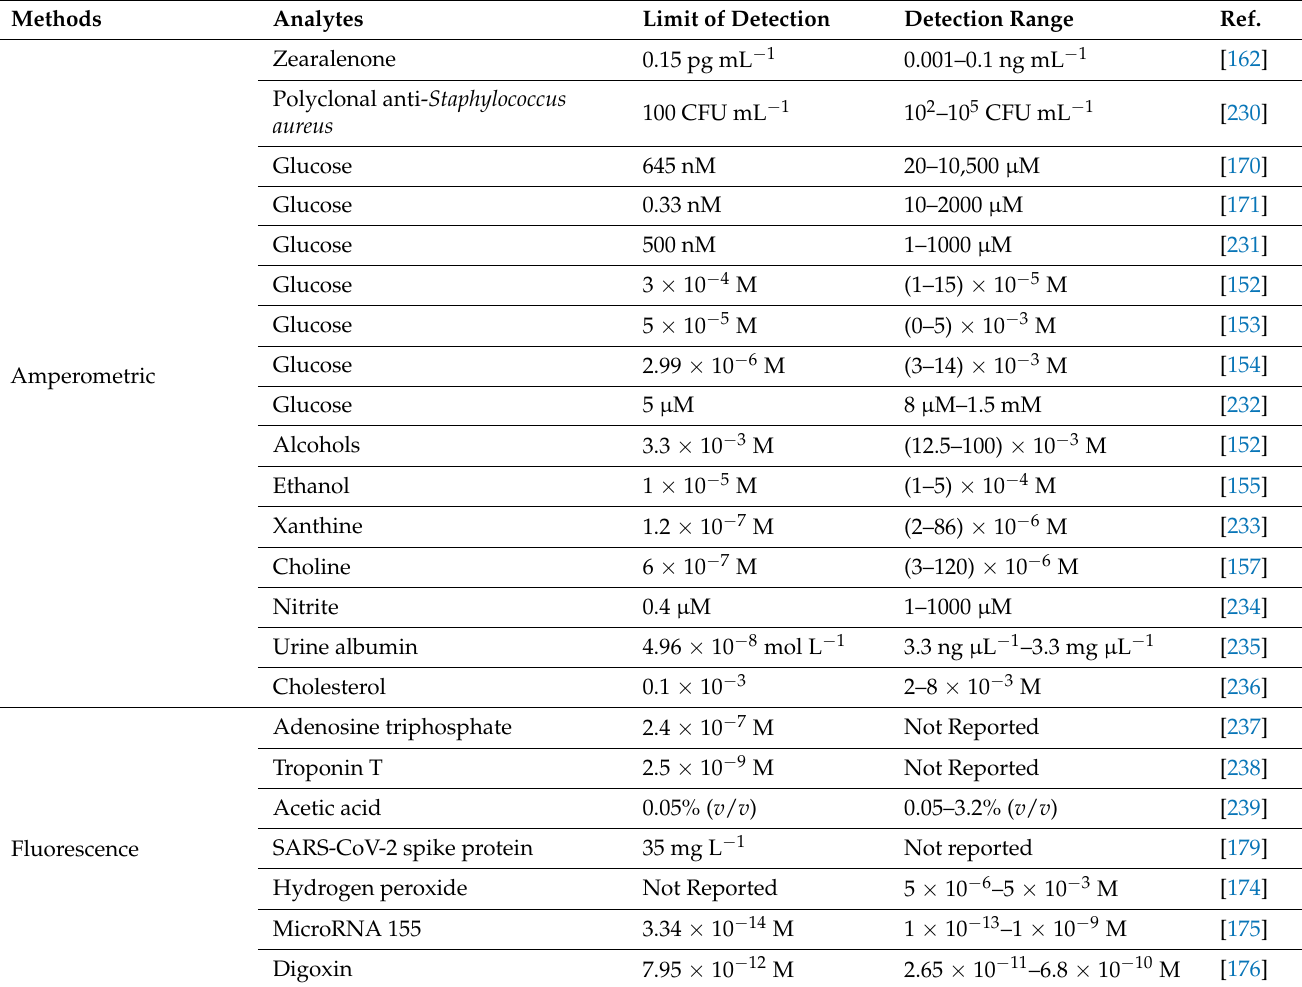
Table 3. CNT-based biosensors on action of detection